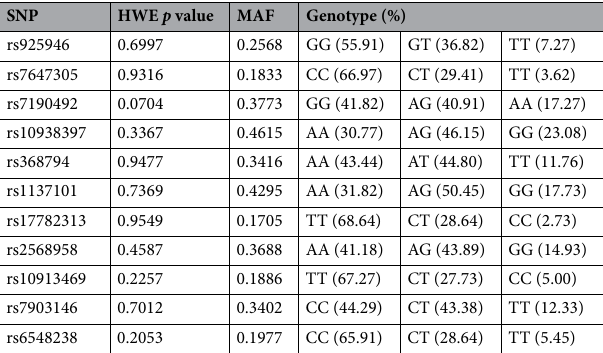
Table 3. Single Nucleotide Polymorphisms selection for the GRS design. SNP single nucleotide polymorphism, HWE Hardy–Weinberg equilibrium, MAF minor allele frequency.